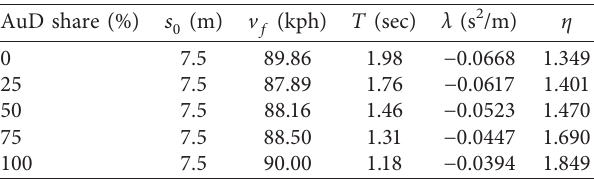
Figure 4: Comparison of the calibrated fundamental diagrams resulting from the macroscopic IDM and proposed traffic flow model on (a) simulation data and (b) empirical data. Table 1: Model parameters of the proposed model for distinct mixed traffic scenarios.